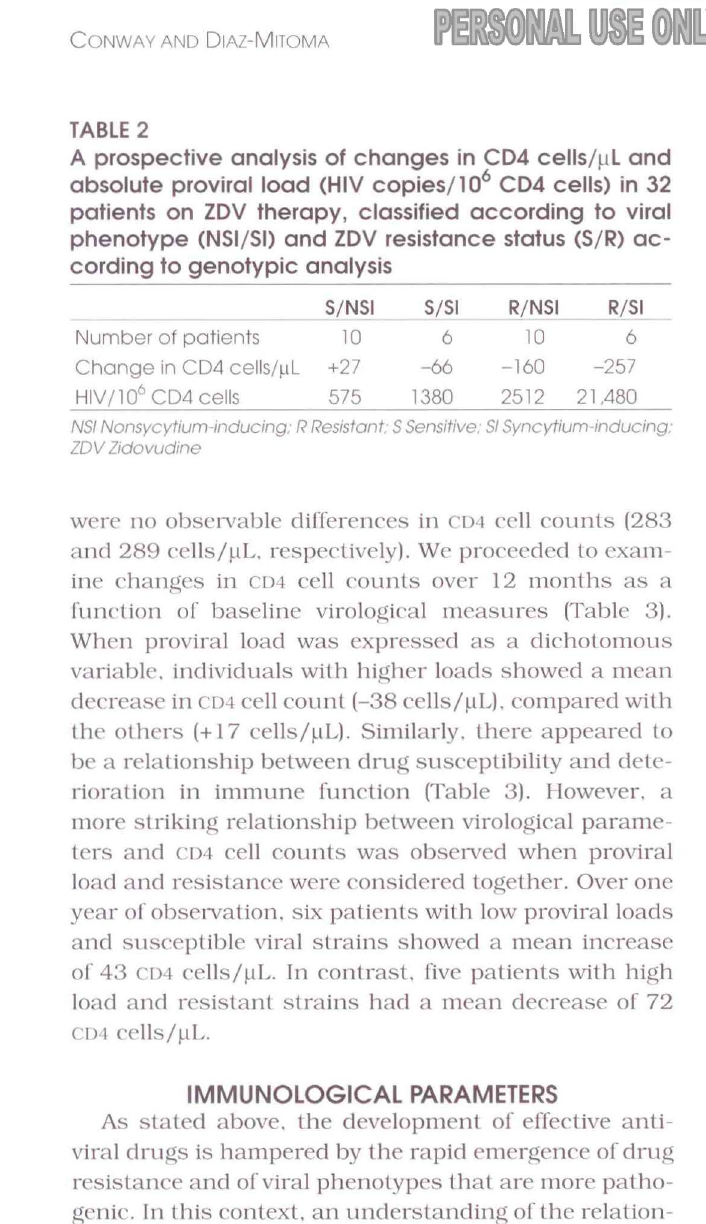
Changes in CD4 cell count over 12 months of observa A prospective analysis of changes in CD4 cells/µL and tion, expressed as a function of proviral load and drug absolute proviral load (HIV copies/ 10 6 CD4 cells) in 32 susceptibility, considered individually or as a composite patients on ZDV therapy, classified according to viral phenotype (NSI/SI) and ZDV resistance status (S/ R) ac virological cording to genotypic analysis S/ NSI